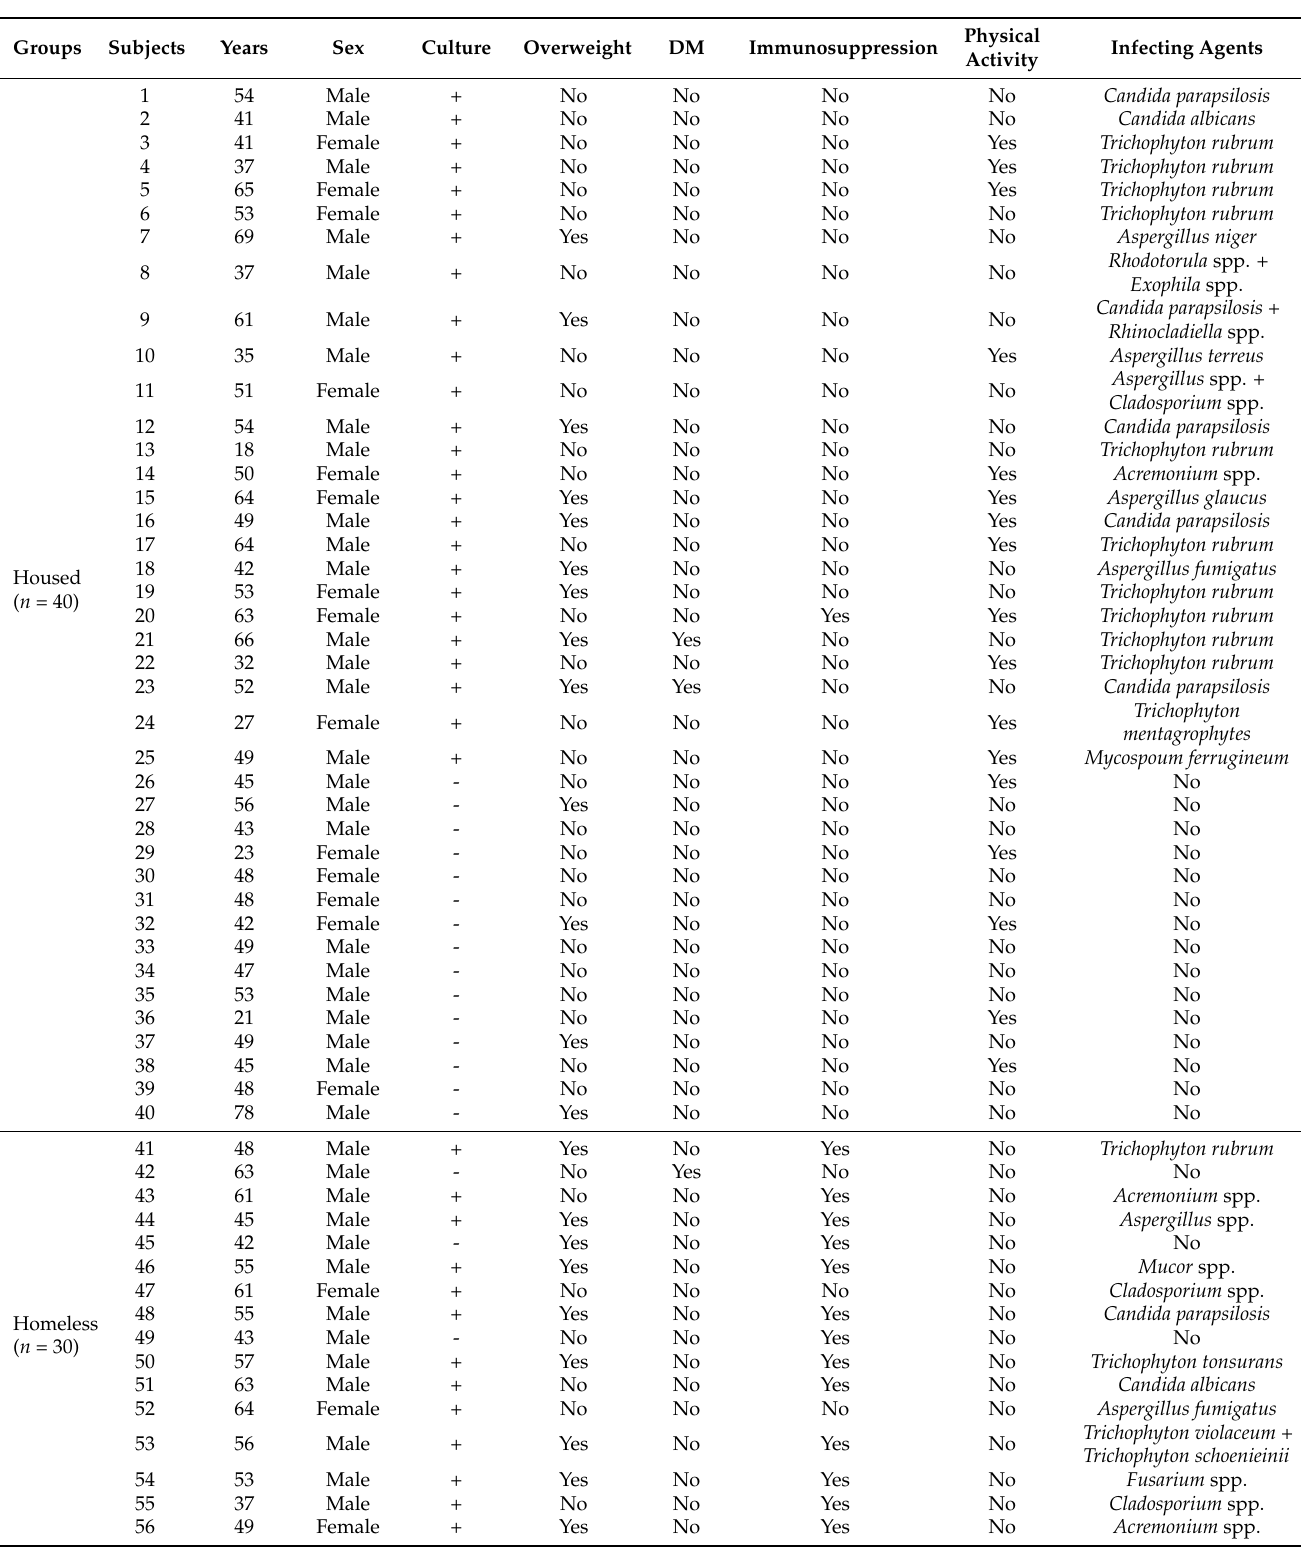
Table 1. Sociodemographic characteristics, confounding variables and identified infectious agents ( n =